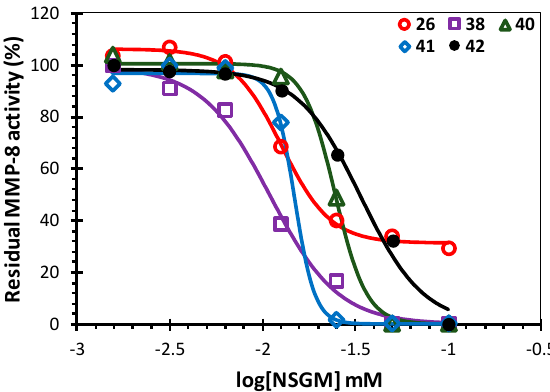
Figure 4. Direct MMP-8 inhibition profiles of the most promising NSGMs, including 26 , 38 , 40 , 41 , and 42 , at pH 7.5 and 37 ◦ C. Solid lines represent the data fitted to the standard sigmoidal dose − response equation to derive IC 50 and ∆ Y, which refer to the potency and e ffi cacy of inhibition, respectively.